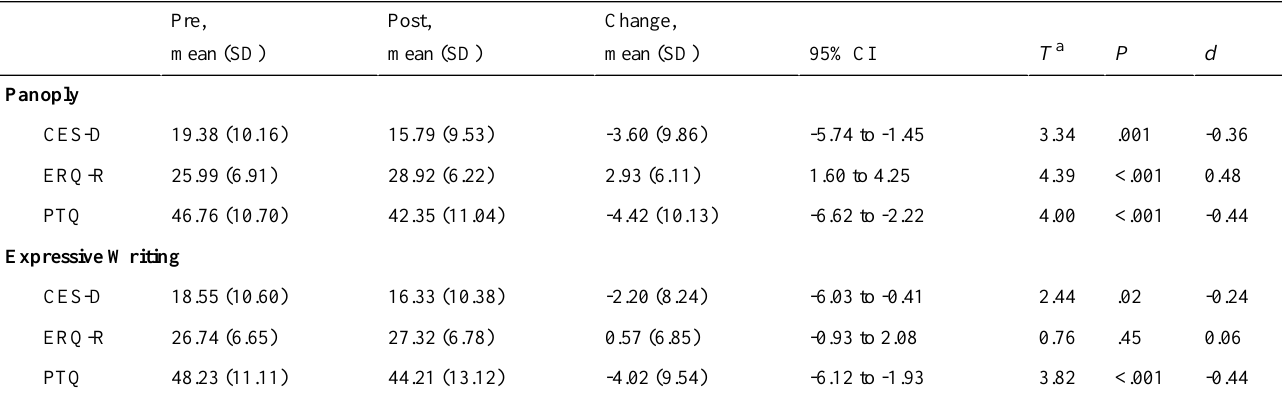
Table 2. Changes from baseline to post-intervention by condition.